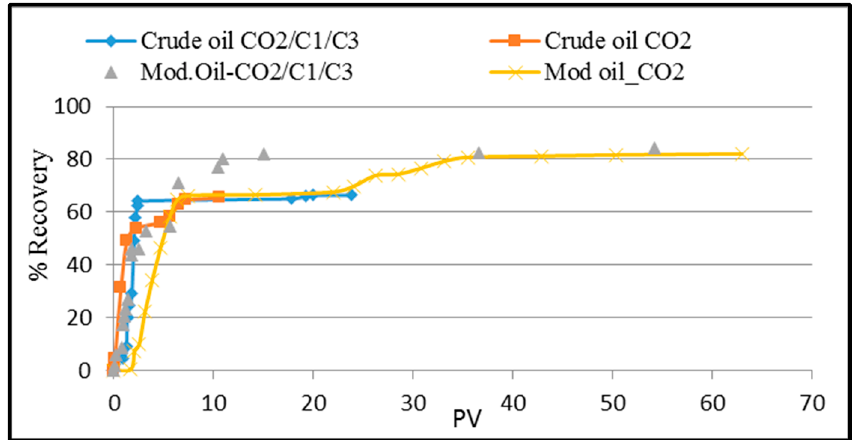
Figure 4. Comparison between the recovery of crude and model oils flooded with CO 2 and CO 2 /C1/C3 at 70 °C and 200 bar.